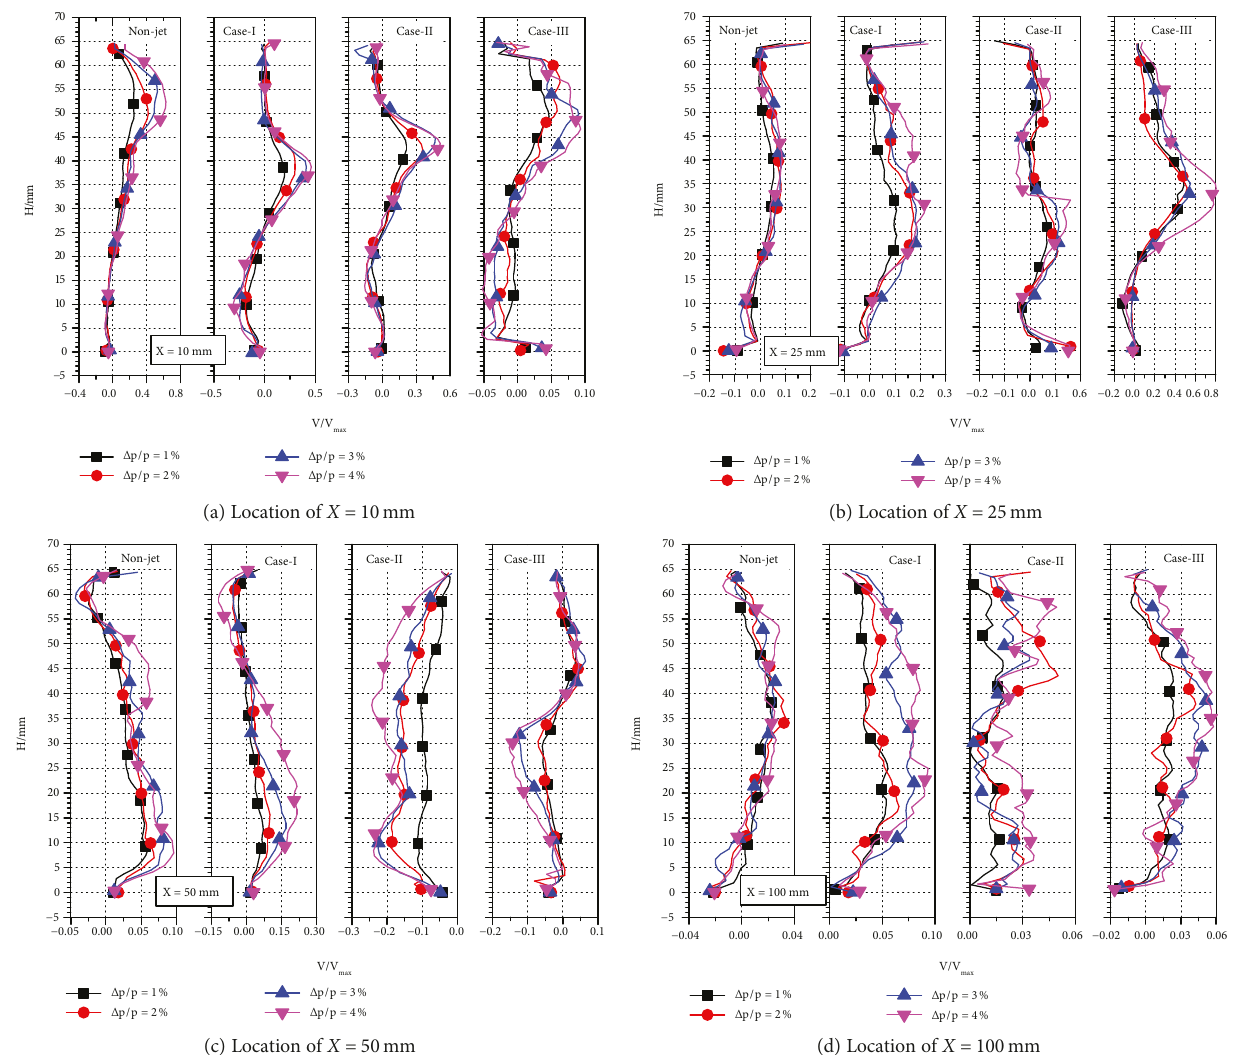
Figure 9: Radial velocity along the Y direction at di ff erent axial locations on the Z = − 15 5 mm